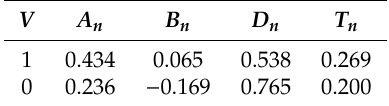
Table 5. Parameters of parameters of post distribution in the transformed